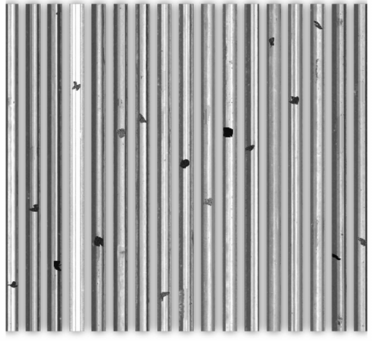
Figure 6. Image of rail surface masked by random